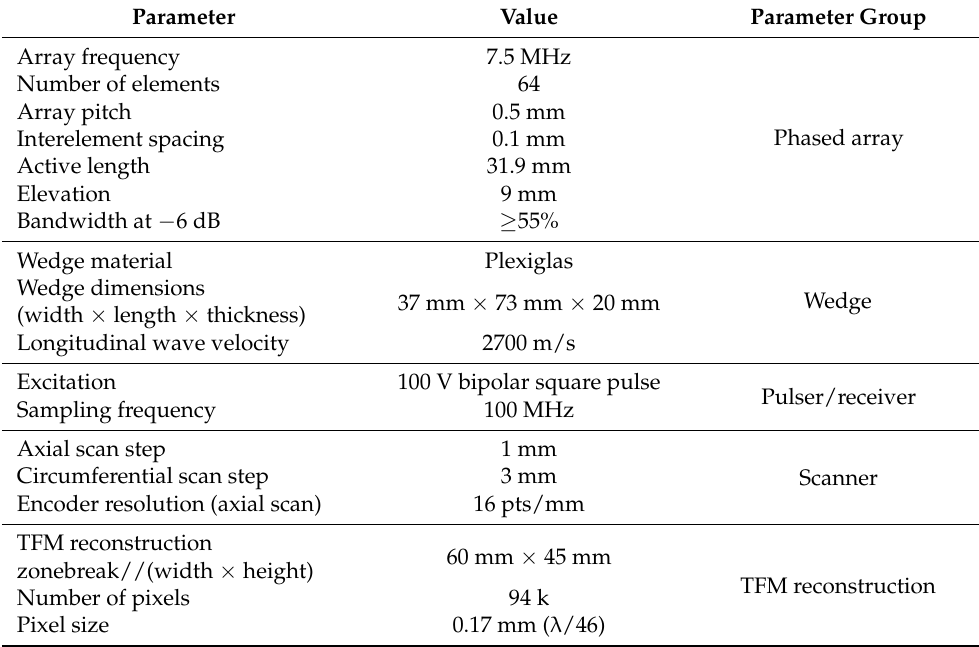
Table 3. The phased array, wedge, pulser, scanner and reconstruction parameters used in the experiments. Parameter Value Parameter Group Array frequency 7.5 MHz